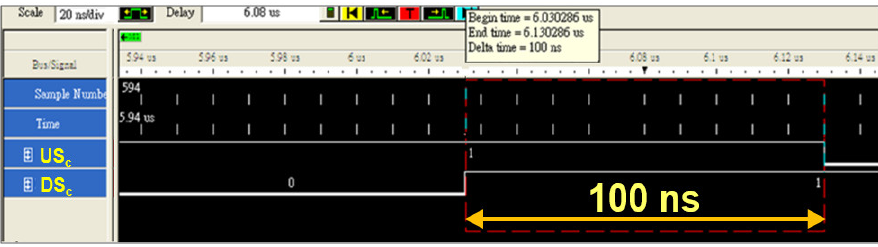
Figure 19. Dead time of 100 ns measured in the W-phase by using the logic analyzer.